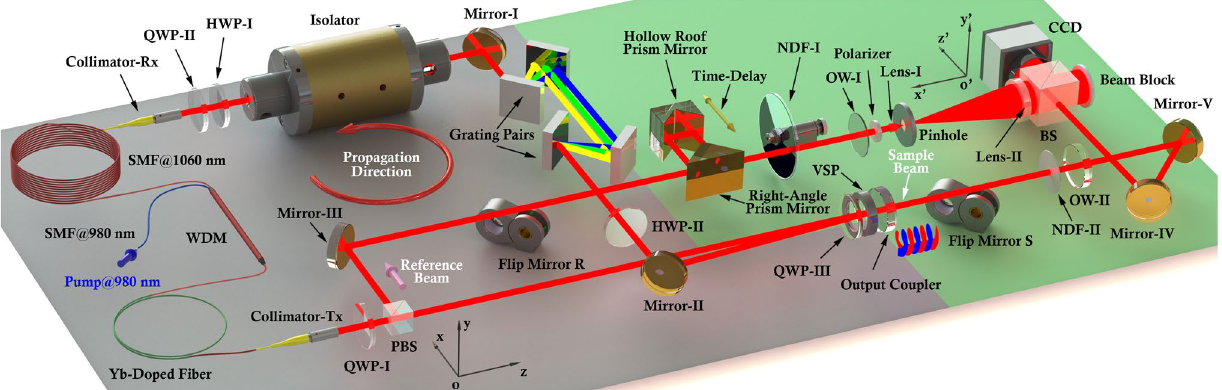
Figure 1. Schematic diagram of the integrated pulse scope. The gray portion of the background floor highlights the intracavity-controlled femtosecond laser, whereas the green portion of that describes the polarization- sensitive spatiotemporal characterization system. VSP = variable spiral plate; QWP = quarter wave plate; HWP = half wave plate; SMF = single mode fiber; WDM = wavelength division multiplexer; BS = beamsplitter; PBS = polarizing beamsplitter; OW = optical window; NDF = neutral density filter. The red circular arrow denotes the direction of the cavity